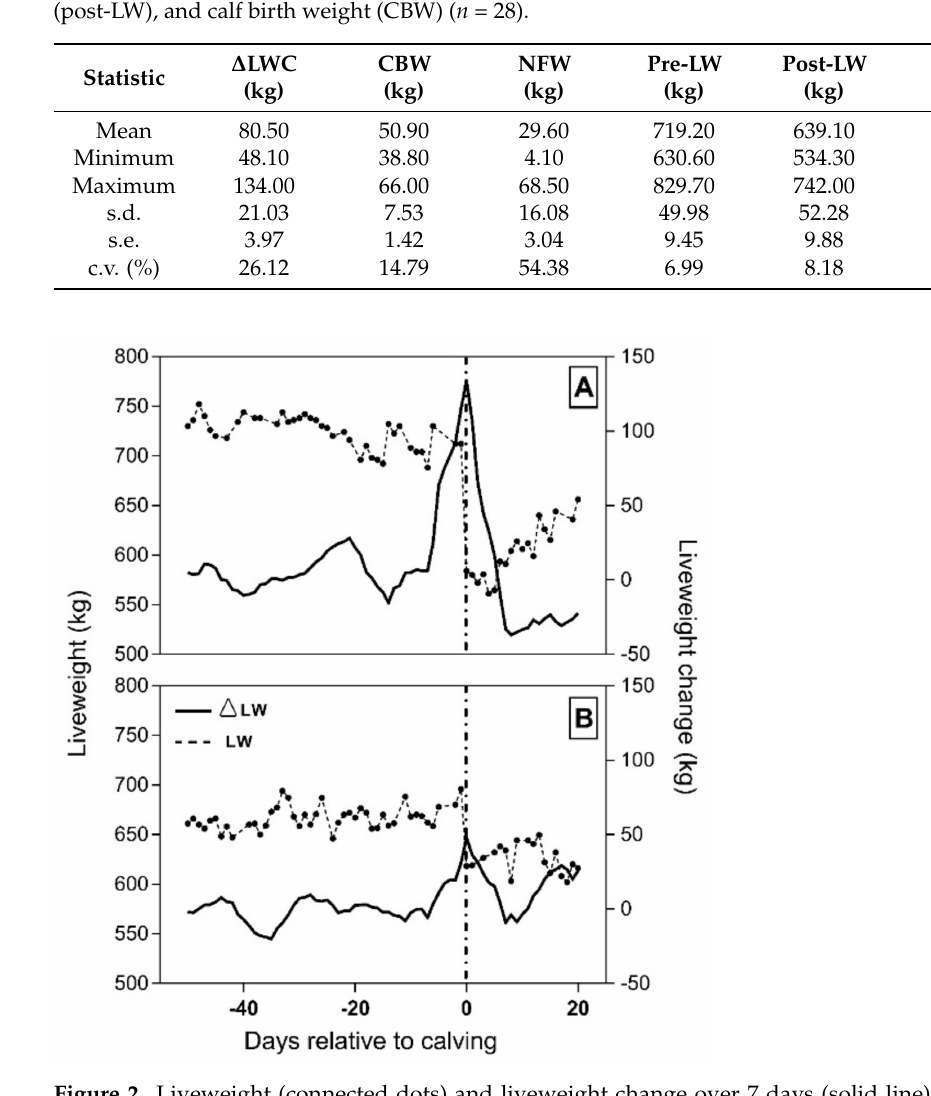
Figure 2. Liveweight (connected dots) and liveweight change over 7 days (solid line) for a cow experiencing high weight loss ( A ) and low weight loss ( B ) at calving. A single dot represents the daily averaged LW for both cows. Calving (dashed vertical reference line) occurred for ( A ) on 29 August 2017 when ∆ LWC peaked at 112.90 kg and for ( B ) on 20 August 2017 when ∆ LWC peaked at 60.43 kg. Positive correlations were identified between ∆ LWC and NFW ( p < 0.001; R = 0.95) and CBW ( p < 0.001, R = 0.76), as well as CBW and NFW ( p = 0.004; R = 0.52; Table 2). As expected, pre-LW was positively correlated with post-LW ( p < 0.001; Table 2). Surprisingly, BCS was negatively correlated with CBW ( p = 0.05; Table